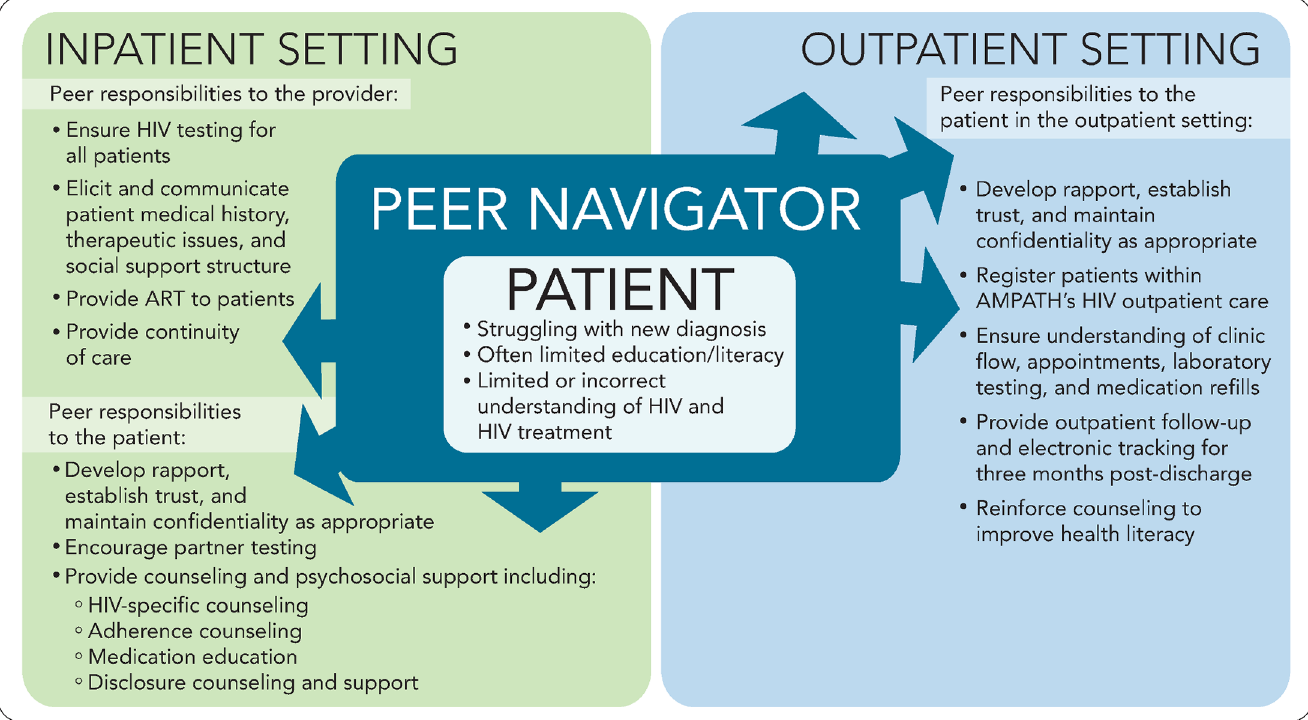
Fig 1. Peer navigator responsibilities. AMPATH, Academic Model ProvidingAccess to Healthcare; ART, antiretroviral therapy.